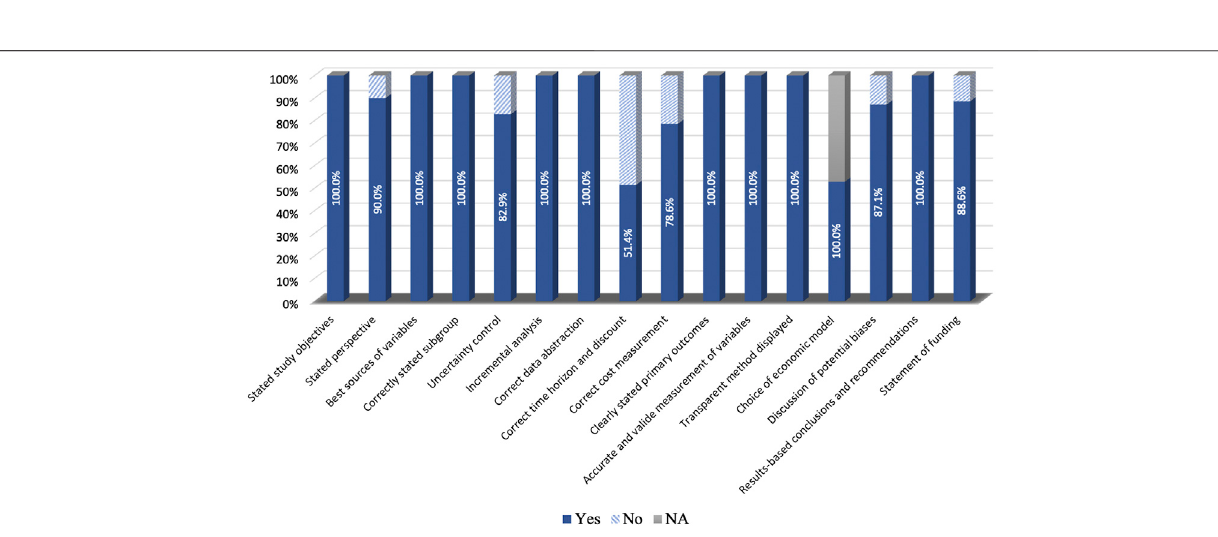
FIGURE 7 | Quality assessment for the included